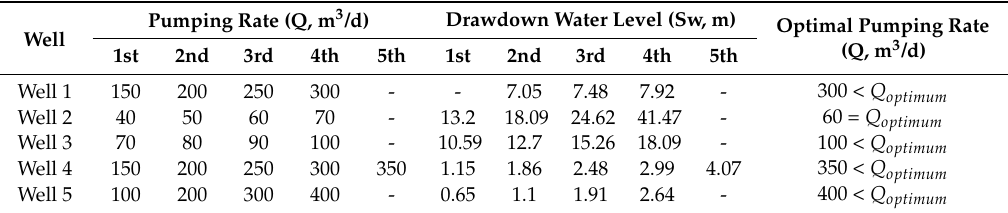
Table 2. Step drawdown test results.